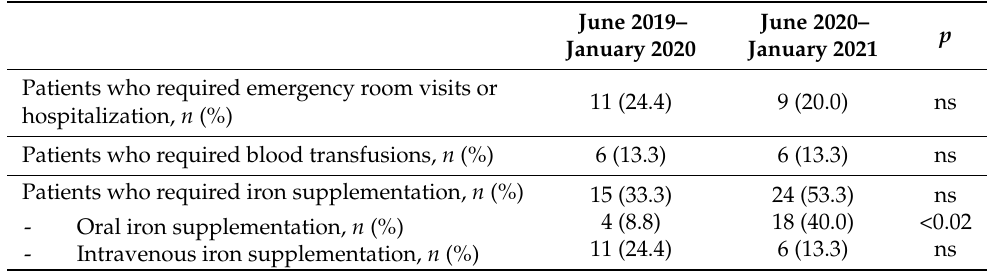
Table 2. Outcomes before and during the COVID-19